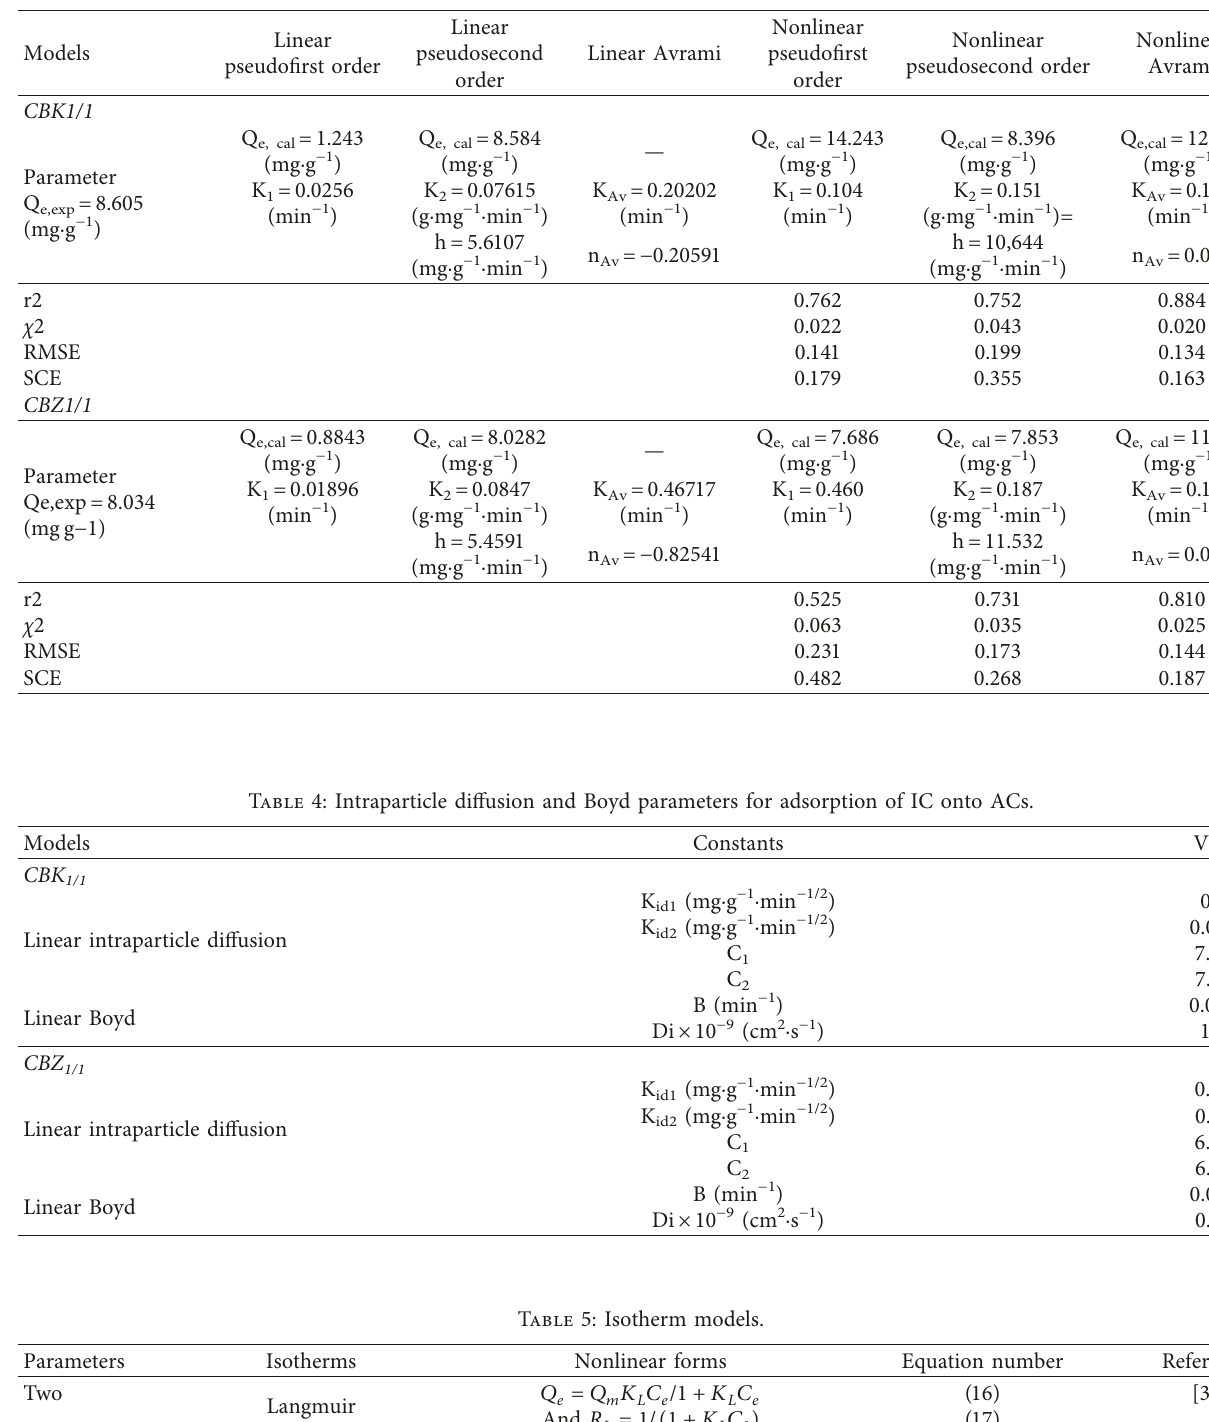
Table 3: Linear and nonlinear parameters of kinetic models for adsorption of IC onto ACs.